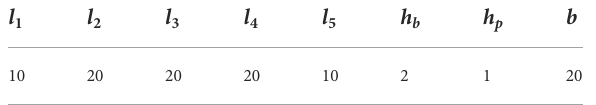
TABLE 1 Geometric parameters